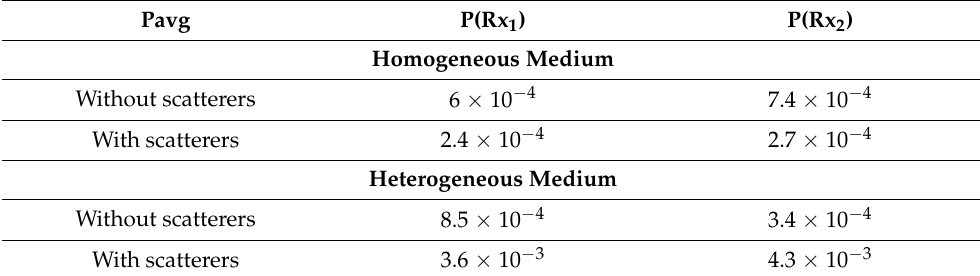
Table 2. Average received power in watts.